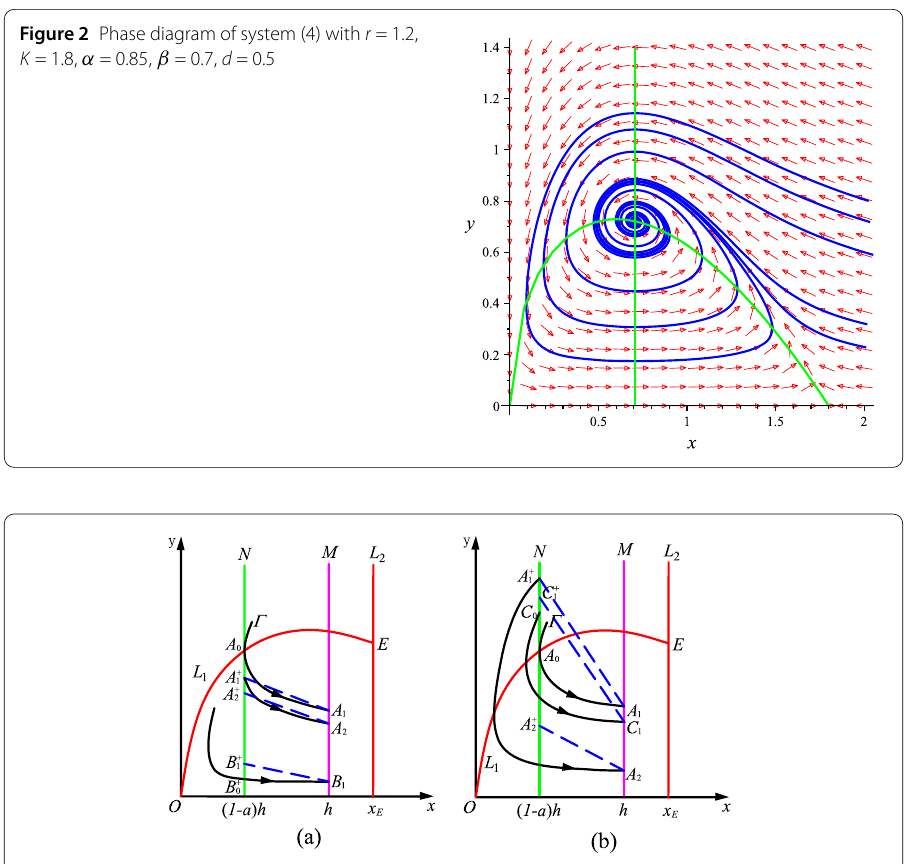
Figure 3 The schematic of the existence of the order-1 periodic solution in Case I. ( a ) Discussion in subcase < y A . ( b ) Discussion in subcase y y A + 1 0